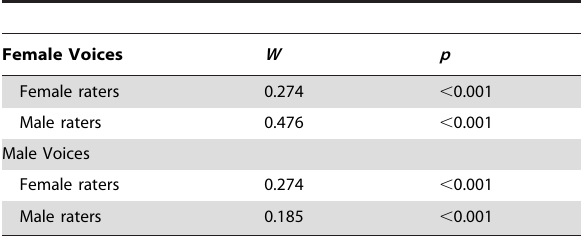
Table 5. Kendall’s coefficient of concordance ( W ) for female and male voices from female and male raters.